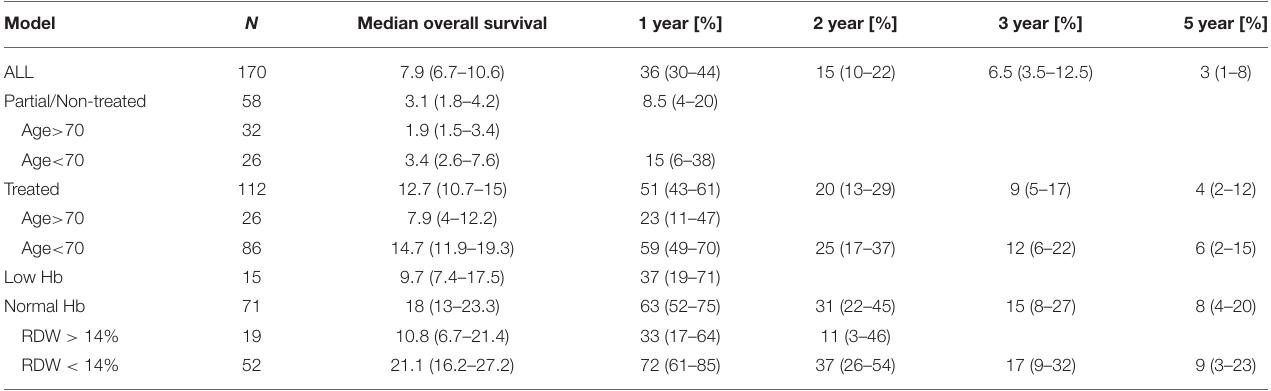
TABLE 4 | Median overall survival patterns of SUMC GBM patients by cohort group stratification.